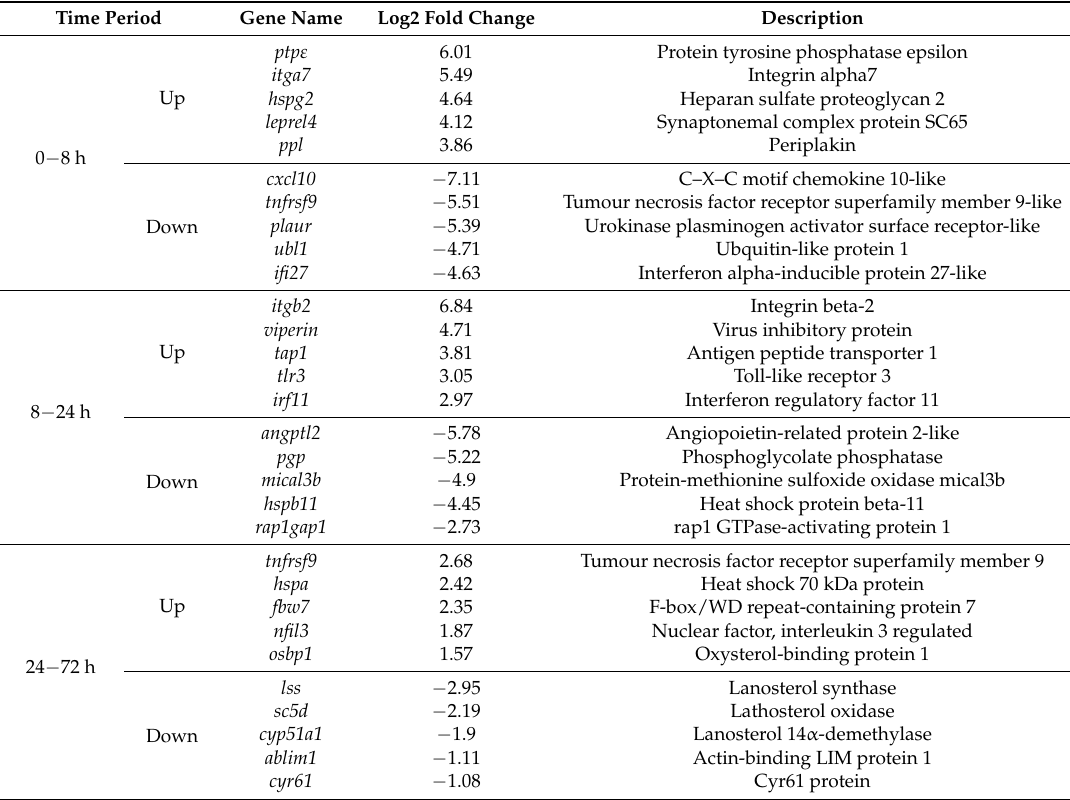
Table 6. Top five up-regulated and down-regulated genes of the three stages following